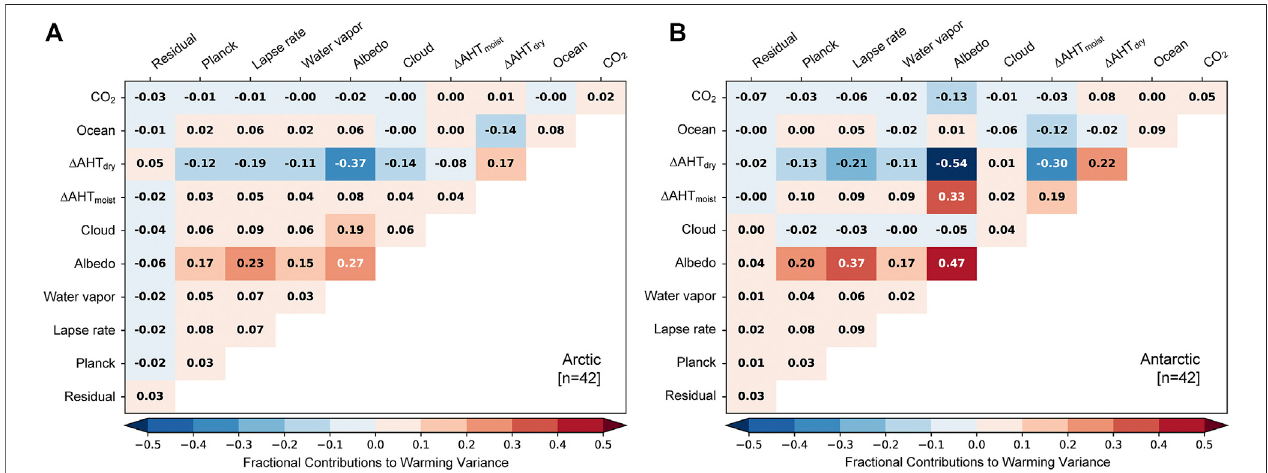
FIGURE 7 | Fractional contributions of each warming contribution term to intermodel variance in (A) Arctic and (B) Antarctic warming in CMIP6.